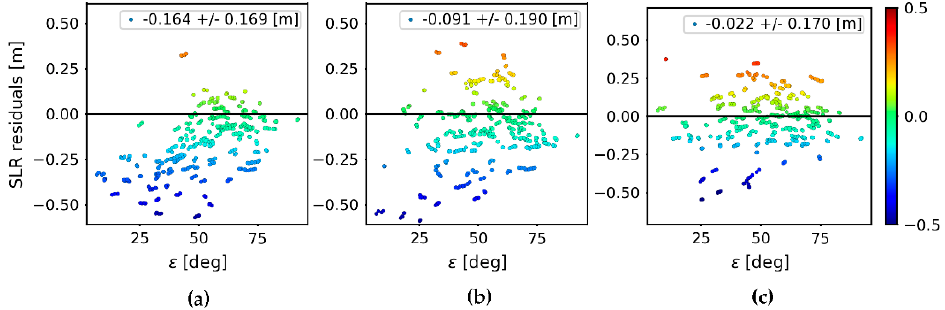
Figure 1. One-way satellite laser ranging (SLR) residuals of ( a ) Extended CODE Orbit Model (ECOM1), ( b ) extended ECOM model (ECOM2), and ( c ) adjustable box-wing model (ABW) orbit solutions of BeiDou-3 I2-S satellite with respect to the ε angle.